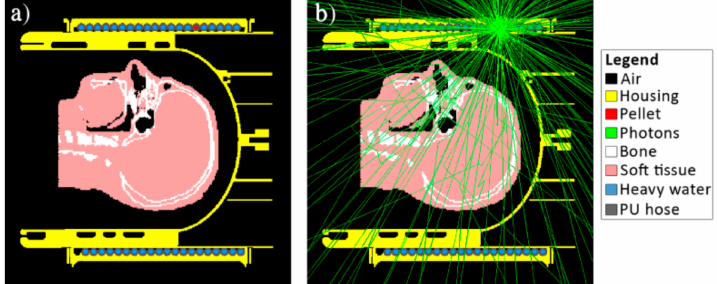
Figure 3. Monte-Carlo simulation of the developed system with a simplified head phantom. Tissue types: Air, bone, and soft tissue. ( a ) Setup without radiation; ( b ) Setup with tracks of the 511 keV annihilation photons (green lines). The coil elements are not visible in the sagittal cuts, as the diameter of these structures is below pixel